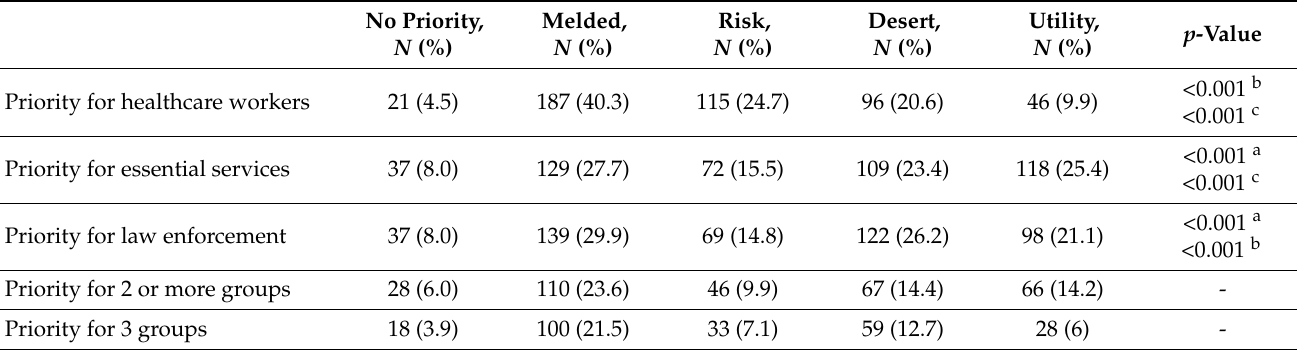
Table 2. Suggested criteria to justify vaccination priority for three different population